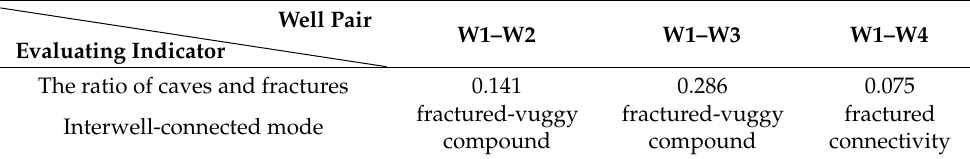
Table 2. The results of static well connected mode of A well group based on the ratio of